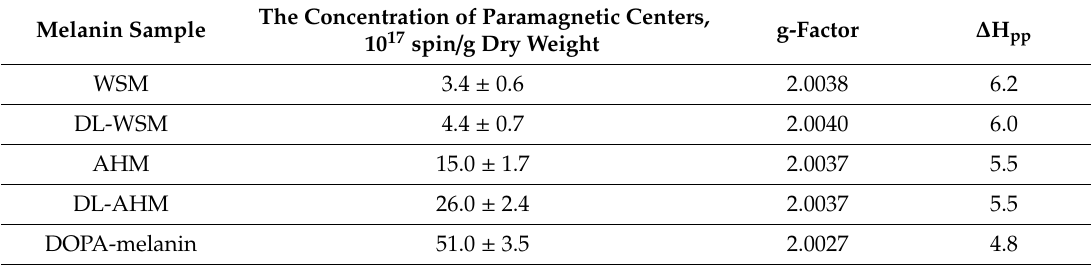
Table 1. Electron spin resonance (ESR) characteristics of the dry samples of black soldier fly (BSF) melanin at room temperature.